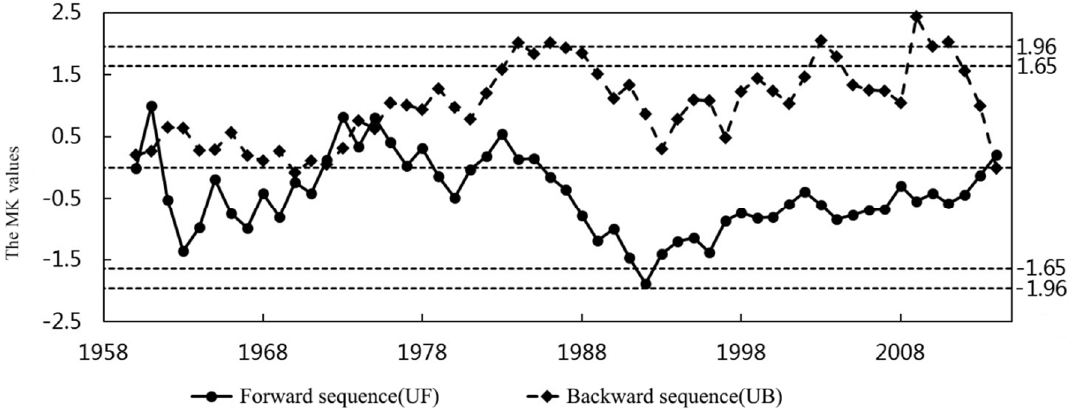
Figure 5. The M–K test results of the annual ETa during 1960–2014 in the Pearl River Basin. UF represents the statistics of forward sequence, UB the statistics of backward sequence.